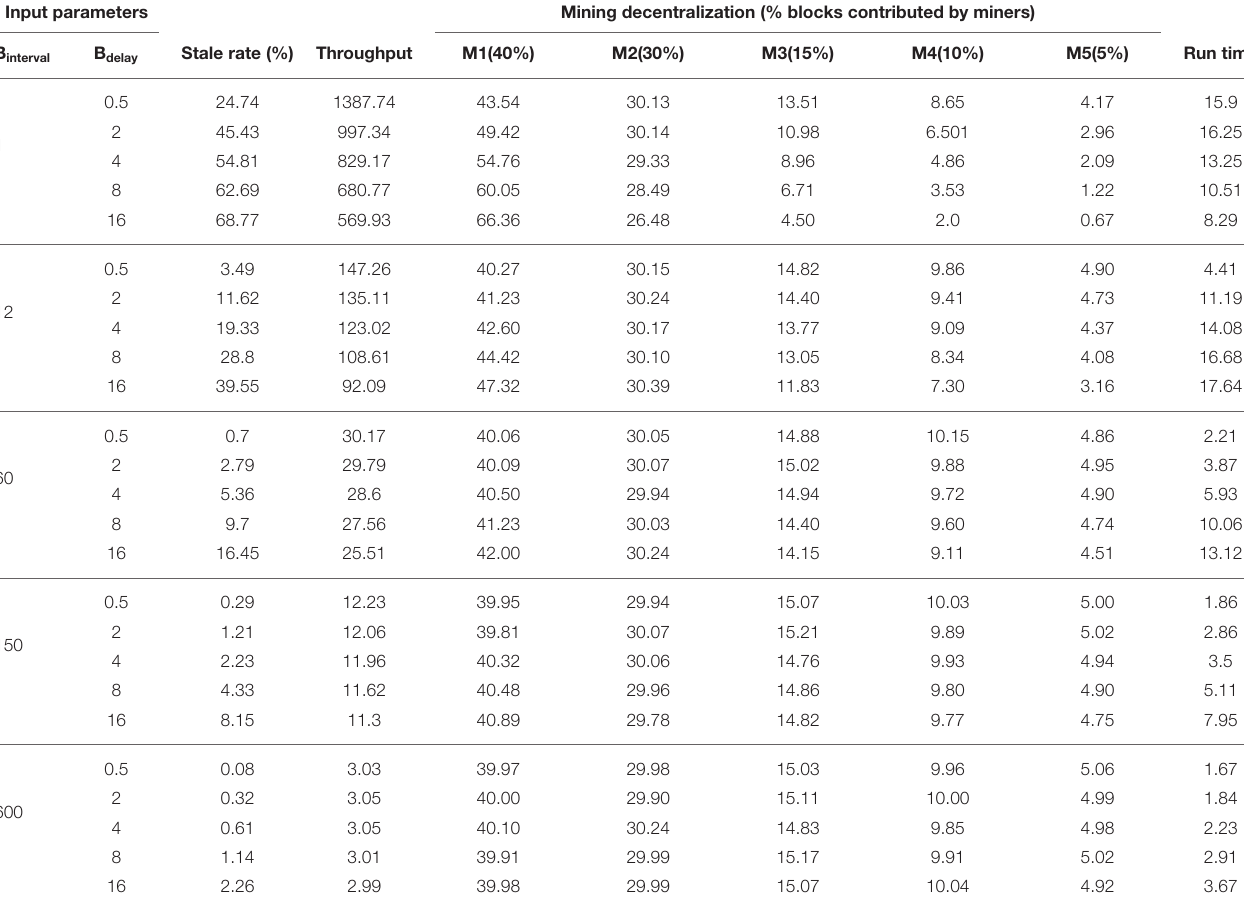
TABLE 5 | The simulation results (stale rate, throughput and the fraction of blocks contributed by each miner) as well as the run time performance (in seconds) for different combinations of block interval and block propagation delay. Input